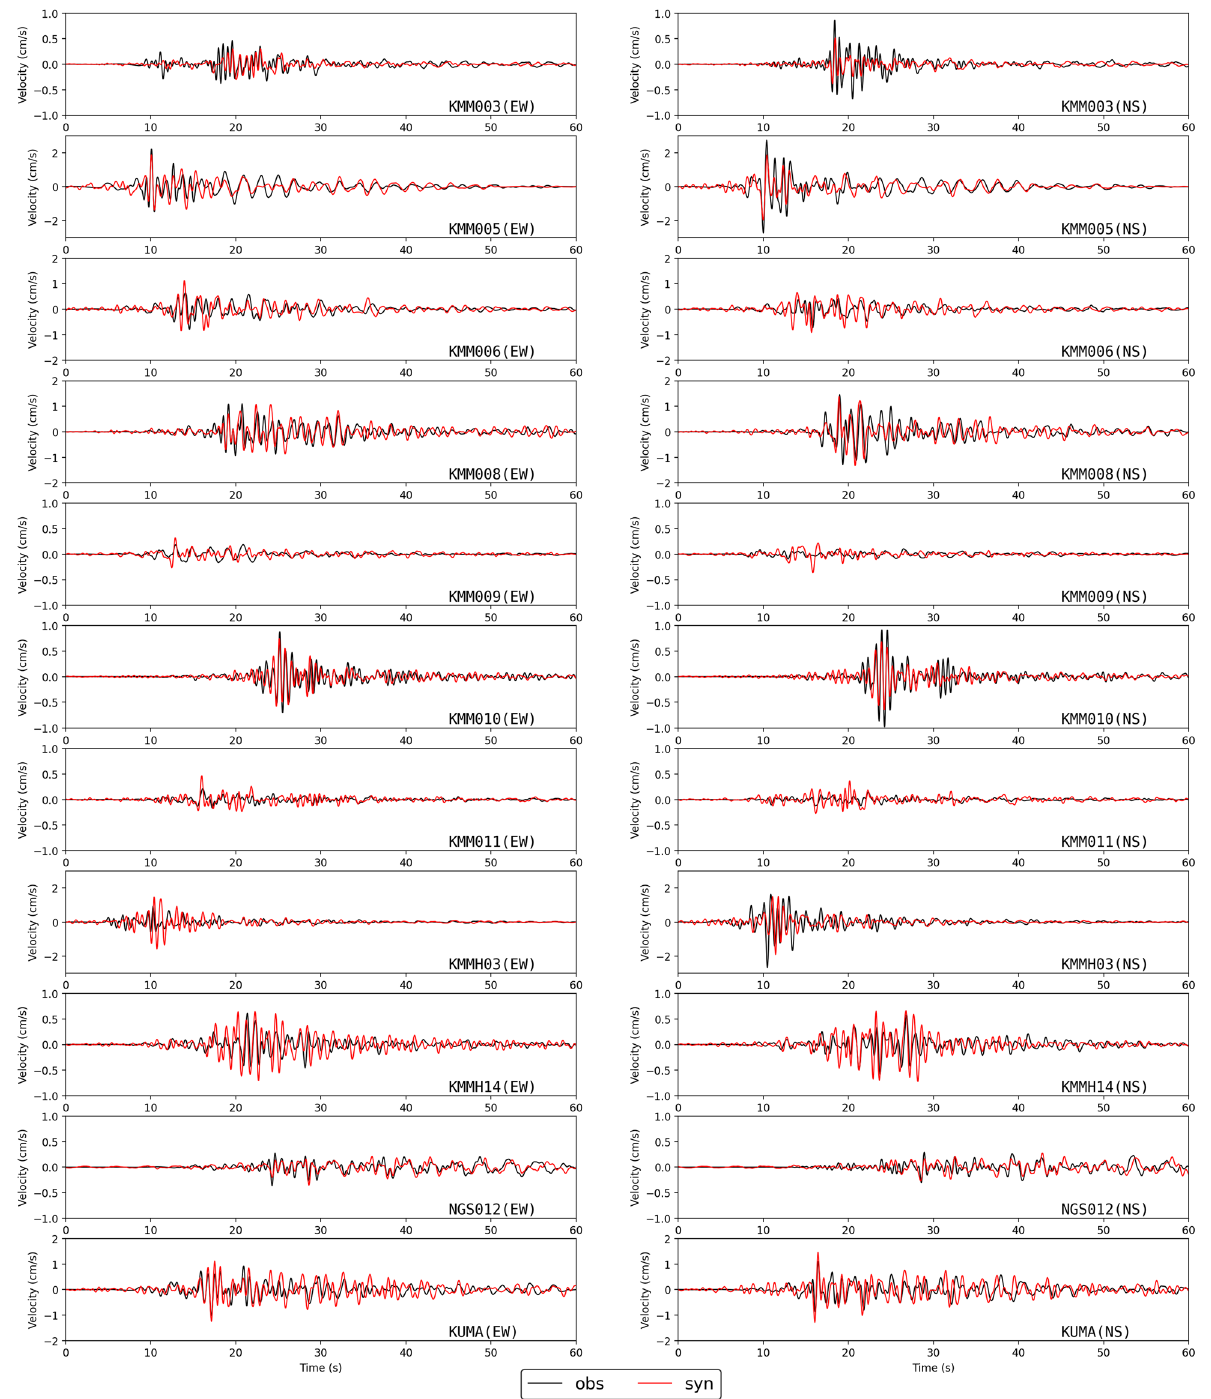
Fig. 6 Synthetic and observed velocity time histories (0.2–2 Hz) for the earthquake of 2016/04/16 03:03 ( M w 5.5). Black lines indicate the observed velocities. Red lines indicate the synthetic